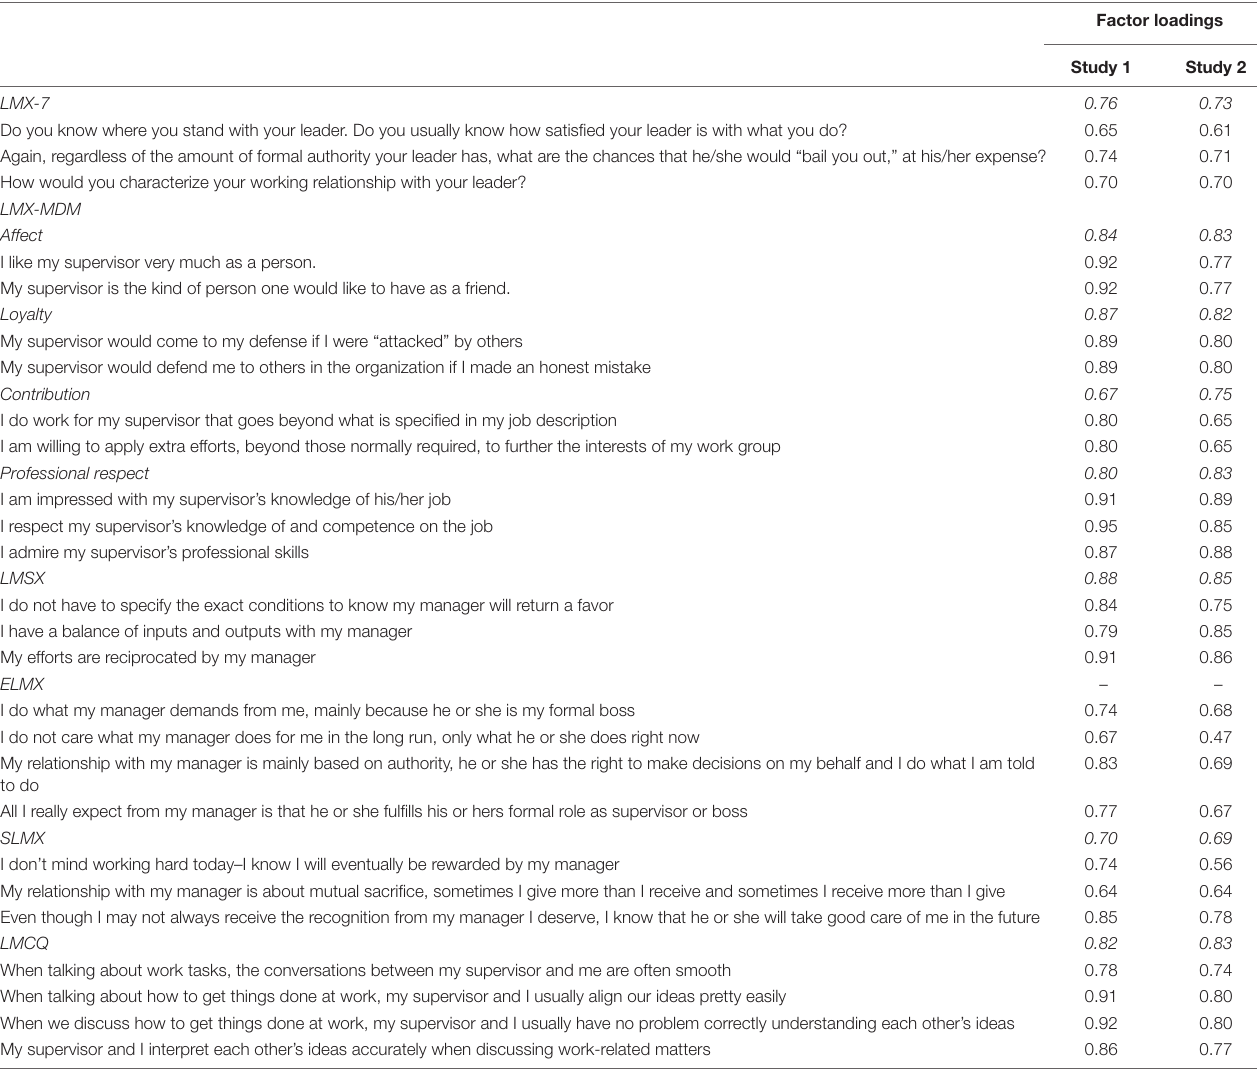
TABLE 2 | Subordinate items and factor